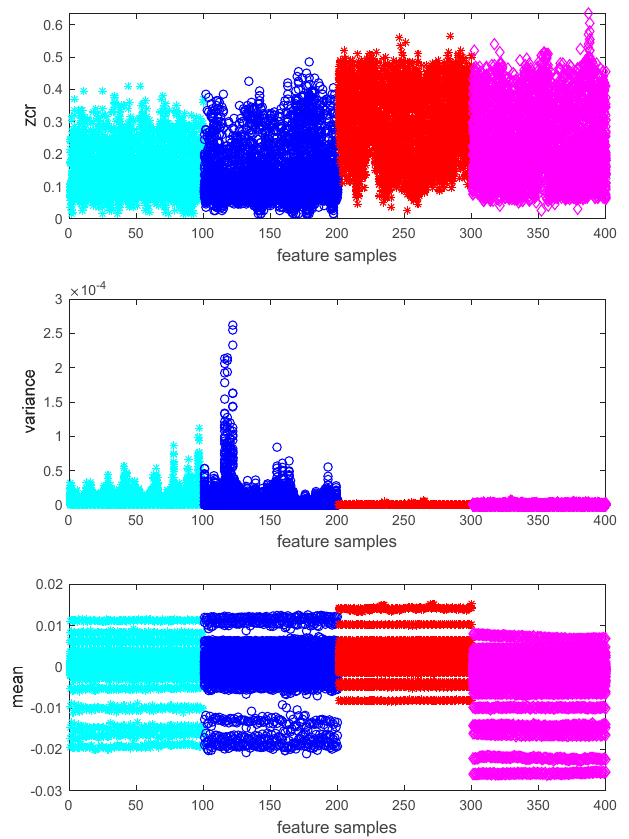
Figure 5. Results of the features extracted from raw data.